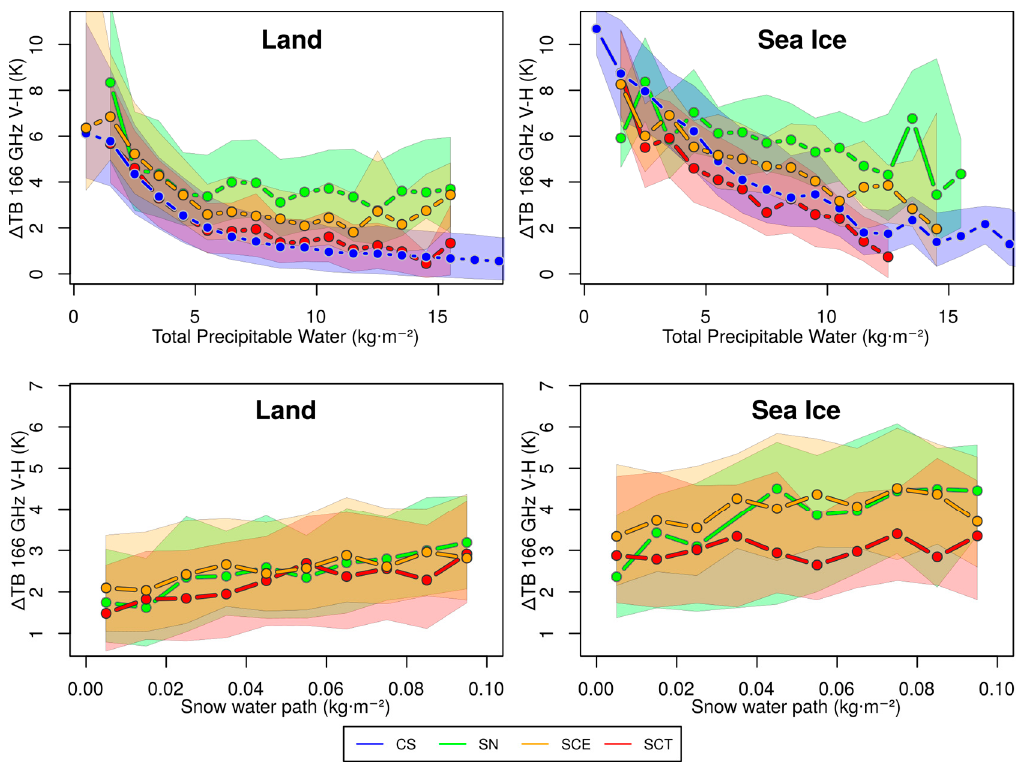
Figure 9. Same as in Figure 8 but for 166 GHz ∆ TB.